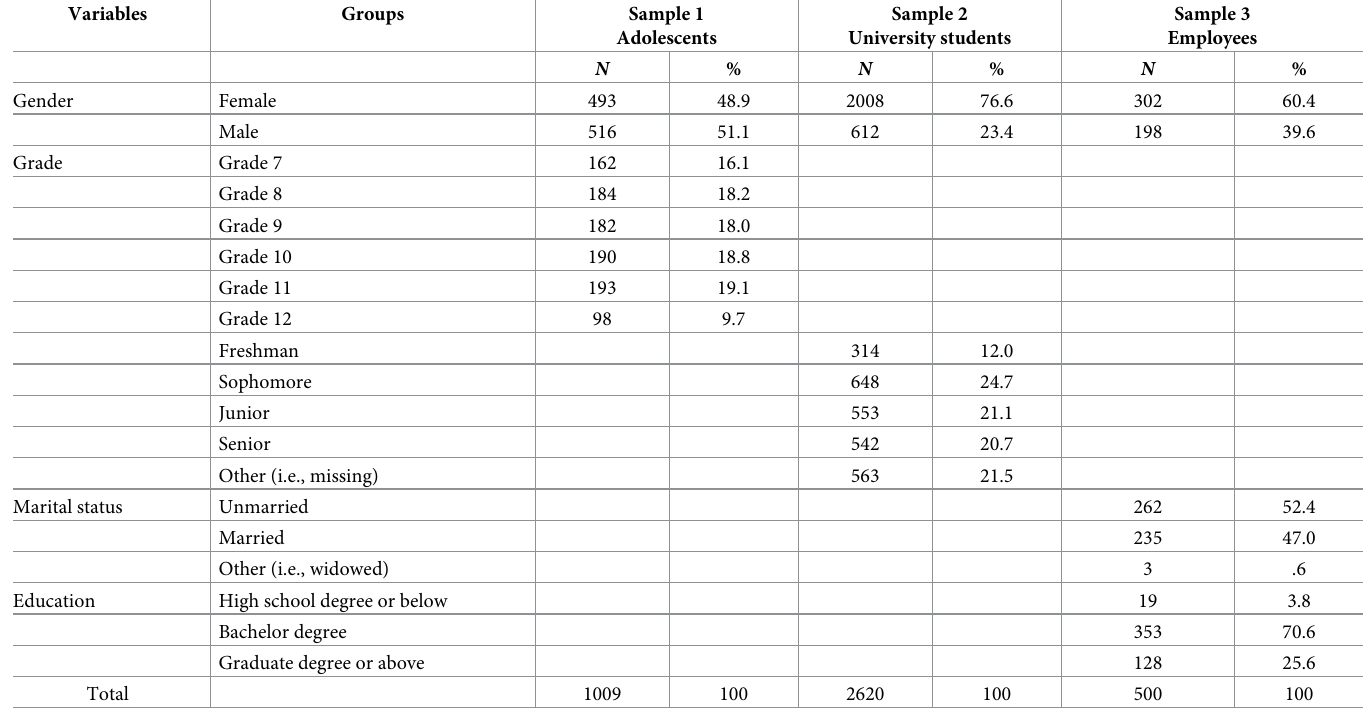
Table 1. Demographic characteristics of the three